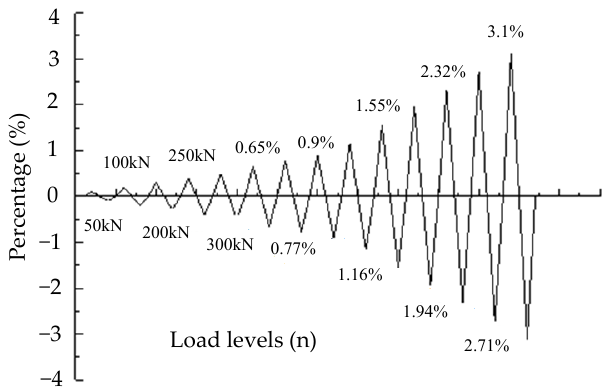
Figure 11. Horizontal cyclic loading regime of specimen 1.